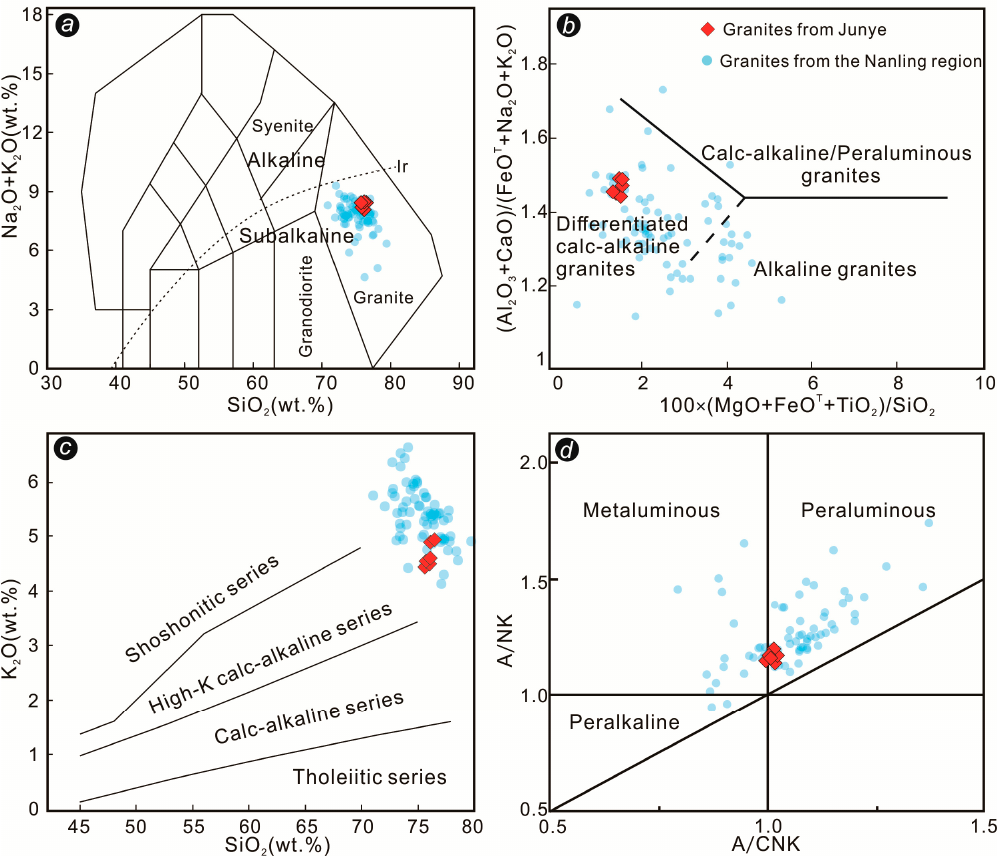
Figure 4. Discrimination diagrams based on major elements: ( a ) Total alkalis–silica (TAS) classification diagram for plutonic rocks (fields after middlemost. [57]) ( b ) Plots of (Al 2 O 3 + CaO)/(FeO T + Na 2 O + K 2 O) vs. 100 × (MgO + FeO T + TiO 2 )/SiO 2 (fields after Sylvester. [58]) ( c ) K 2 O vs. SiO 2 diagram (fields after Peccerillo et al. [59]) ( d ) A/NK vs. A/CNK diagram where A/NK = molar ratio Al 2 O 3 /(Na 2 O + K 2 O), A/CNK = molar ratio Al 2 O 3 /(CaO + Na 2 O + K 2 O) (fields after Maniar et